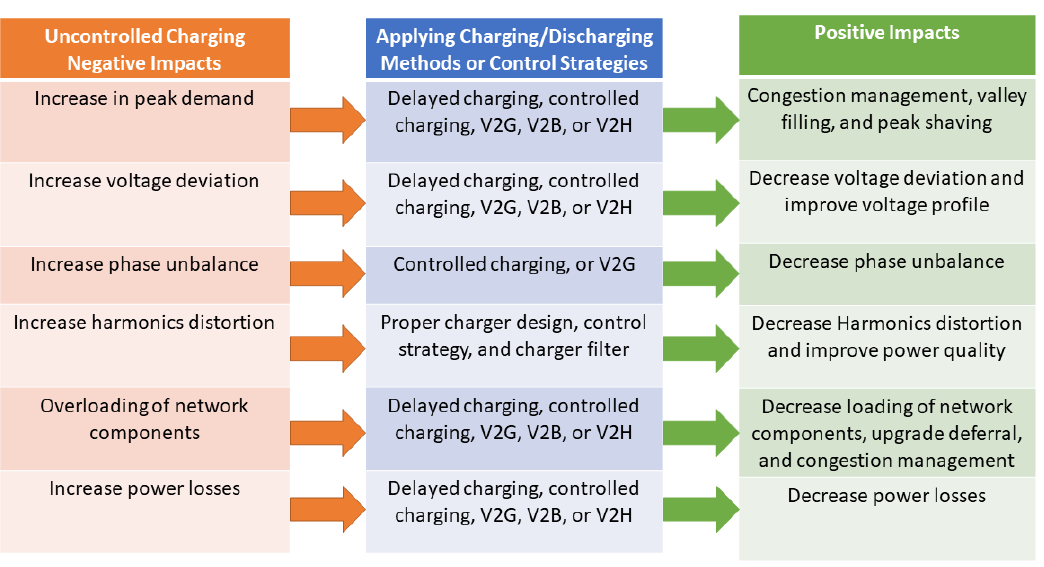
Figure 8. Uncontrolled charging negative impacts on the power system and how it can be mitigated and become positive impact using the proper charging/discharging method.